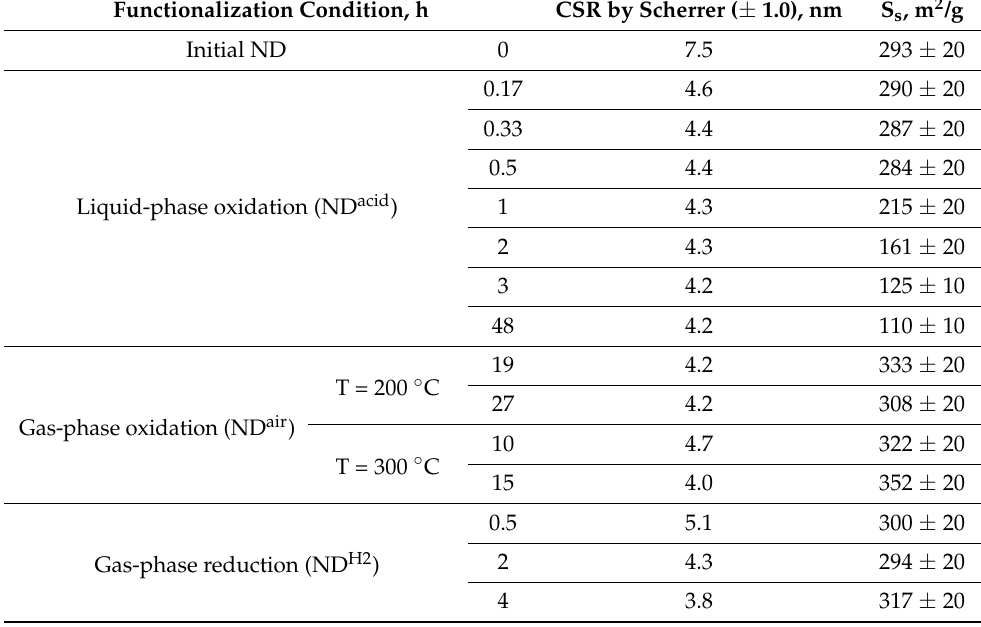
Table 1. The value of the dimensions of the CSR and the specific surface area. Functionalization Condition, h CSR by Scherrer ( ± 1.0), nm S s , m 2